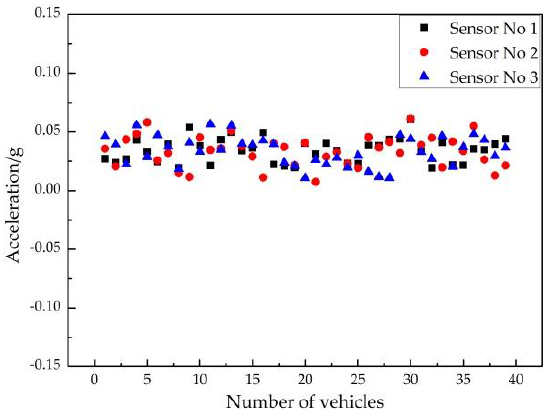
Figure 10. Typical vertical acceleration of Segment 2 in the current monitoring stage.